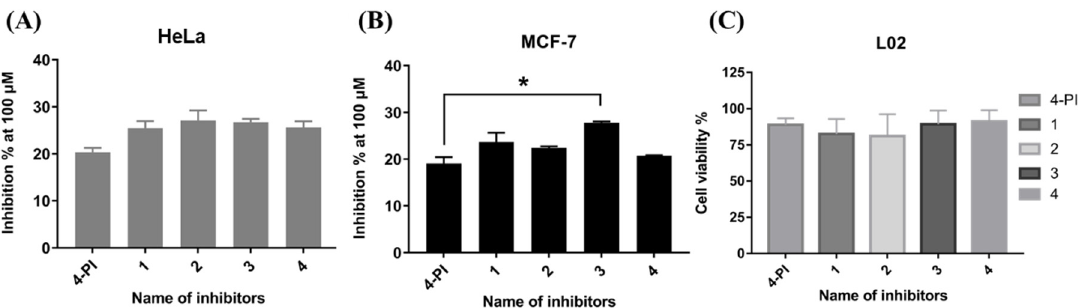
Figure 7. Inhibition percentage of all inhibitors at 100 µ M in HeLa ( A ) and MCF-7 cells ( B ); “two-way ANOVA” method is applied for data analysis. The mark “*” means there is a statistical difference between the two groups ( p < 0.05). ( C ) Cell viability assay for inhibitors using L02. The data are presented as mean ± SD with three independent enzymatic assays. Table 2. Inhibition (%) at 100 μ M inhibitor concentration. a . Compounds